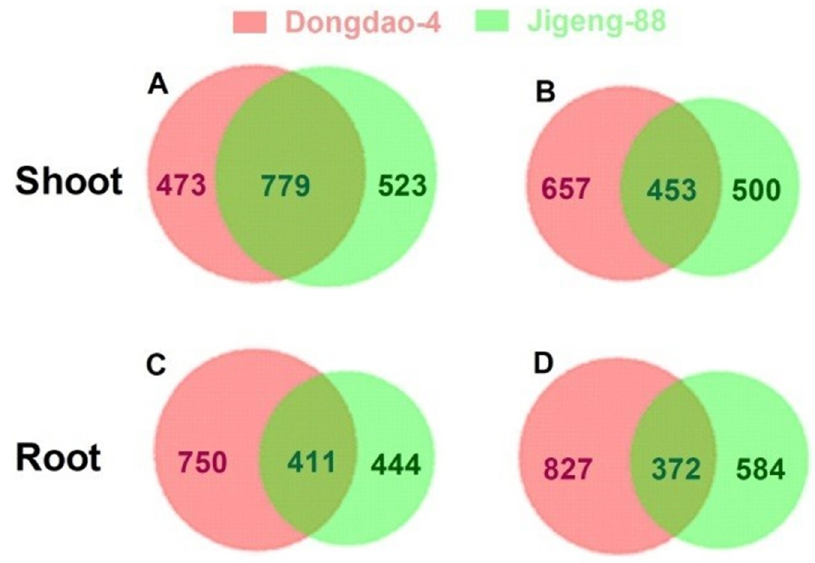
Fig 3. Venn diagram of differentially expressed genes (DEGs) in Dongdao-4 and Jigeng-88. (A) Upregulated DEGs in shoots; (B) downregulated DEGs in shoot; (C) upregulated DEGs in roots; (D) downregulated DEGs in roots. The numbers of genes shared and distinct to each genotype are